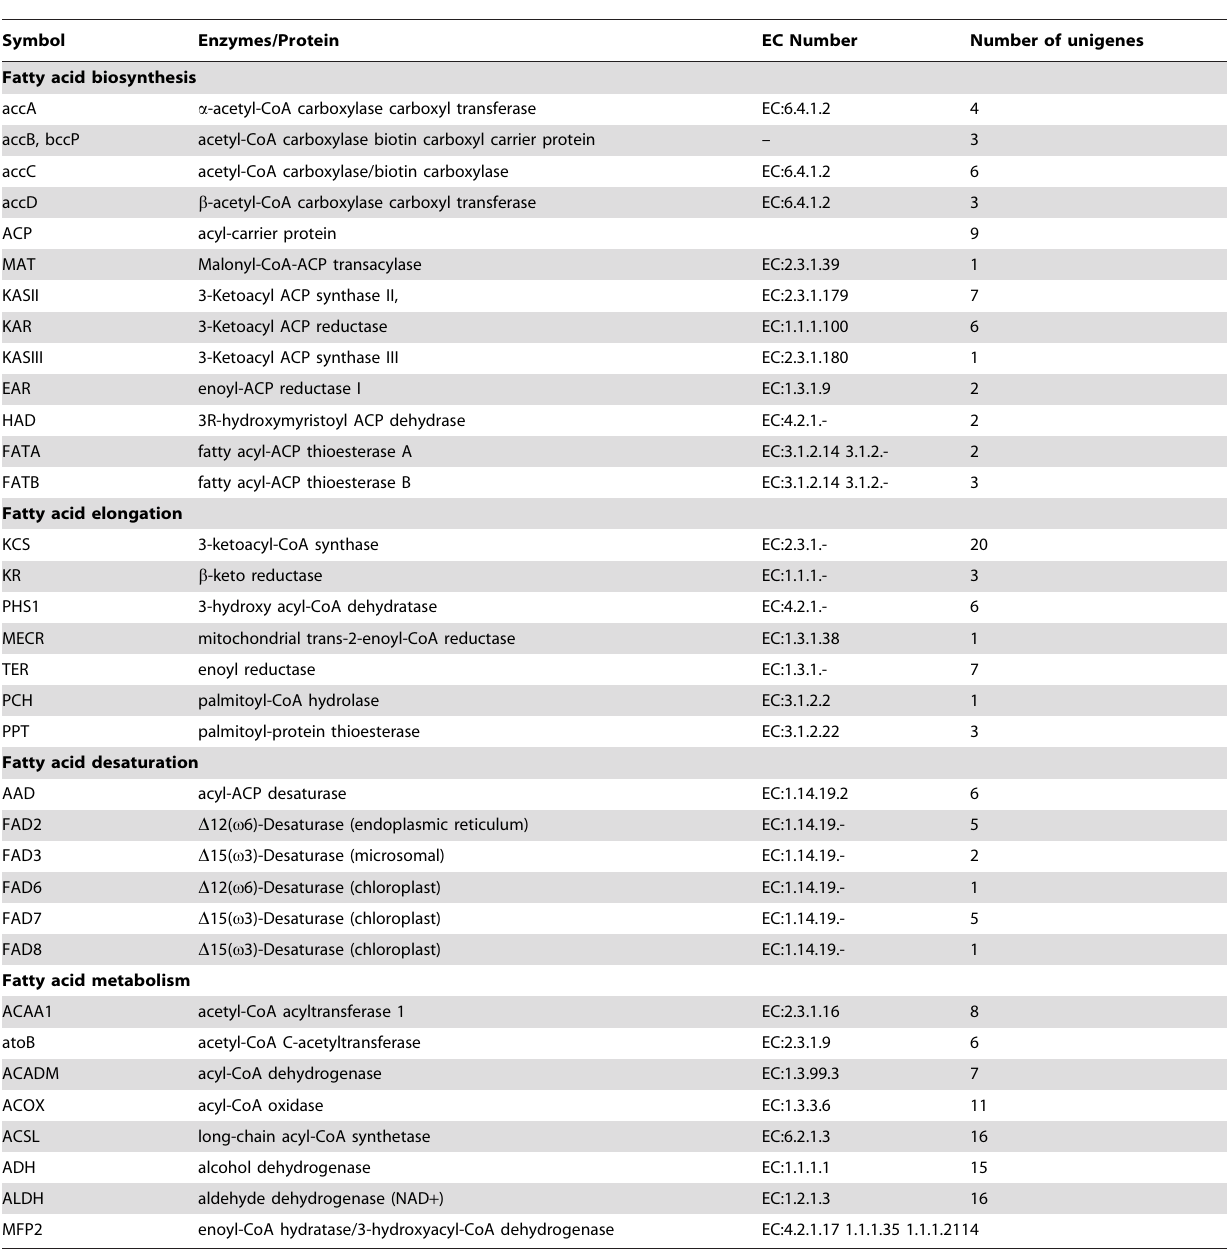
Table 3. Enzymes/protein related to FA biosynthesis and metabolism identified by annotation of the yellow horn unigenes.